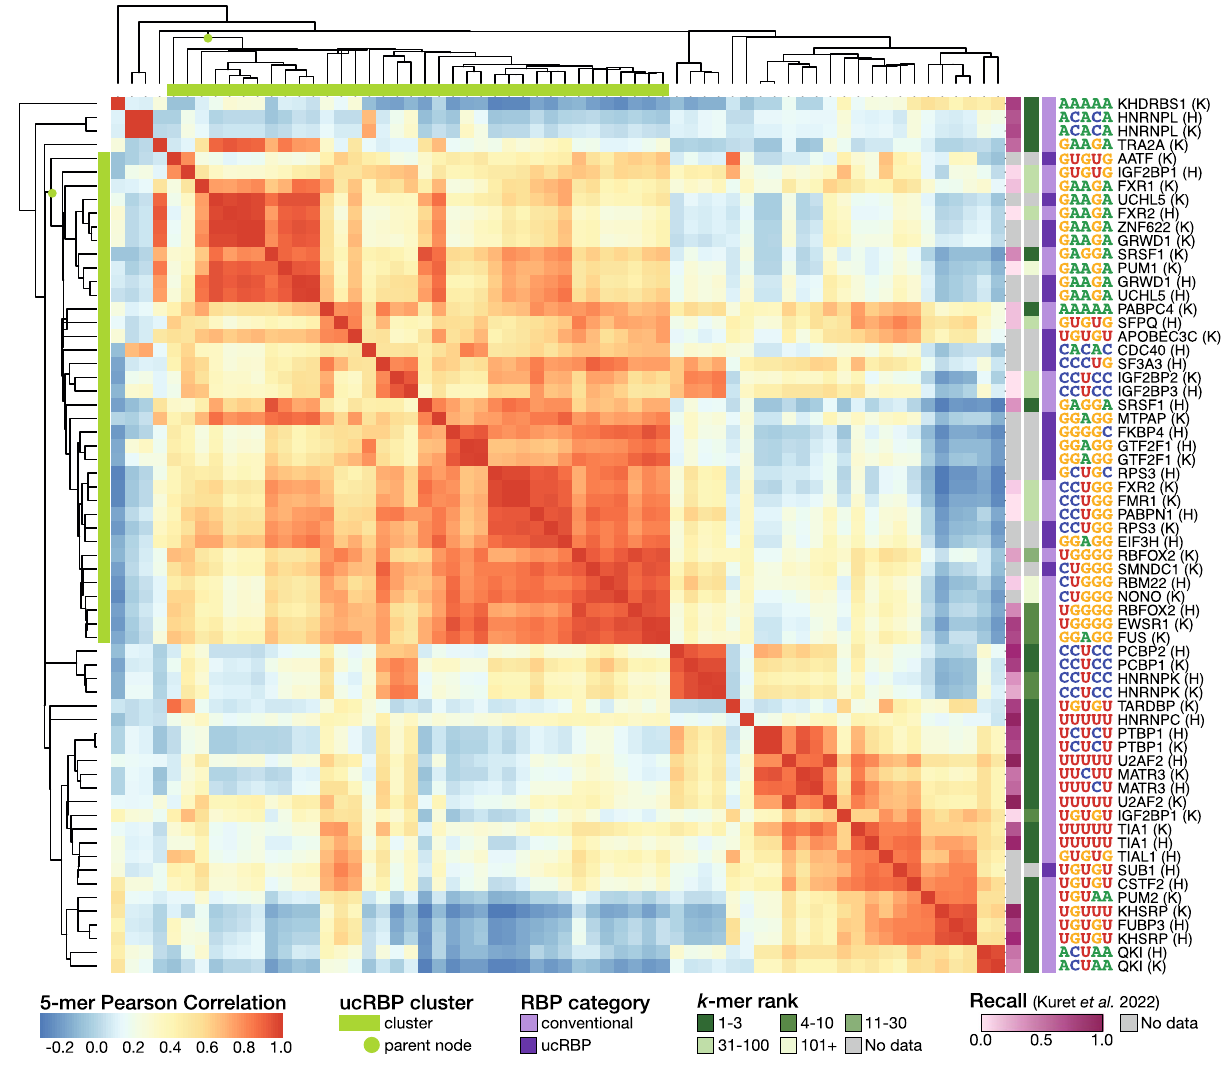
Figure 5. ucRBP eCLIP experiments are not enriched for unique motifs. Heatmap displays Pearson correlations of 5-mer frequencies between 64 eCLIP experiments. 5-mer frequencies were counted in the final set of merged peaks for each experiment as downloaded from ENCODE 46 . To the right of each row the assayed RBP and cell line (K—K562, H—HepG2) are displayed along with the most frequent 5-mer. RBP categories are indicated to the left of the most frequent 5-mer: conventional RBPs contain at least one RRM, KH, or PUF domain or have an in vitro derived motif, whereas ucRBPs are restricted to those that have been assayed by RNAcompete. For conventional RBPs, the first occurrence of the known in vitro derived IUPAC motif in rank ordered 5-mers (k-mer rank) is indicated. IUPAC motifs are available in Supplementary Table S6. Where corresponding RNA Bind-n-Seq (RBNS) data is available, the recall of the top eCLIP motif in the RBNS dataset, as calculated in Kuret et al. 72 is shown. Higher values indicate better correspondence between eCLIP and RBNS experiments. Finally, at the top and left of the heatmap, the "ucRBP cluster" containing all but one of the ucRBPs is indicated with a green bar and the parent node of the cluster is highlighted. The heatmap was generated in R (version 4.1.3) using the pheatmap package (version